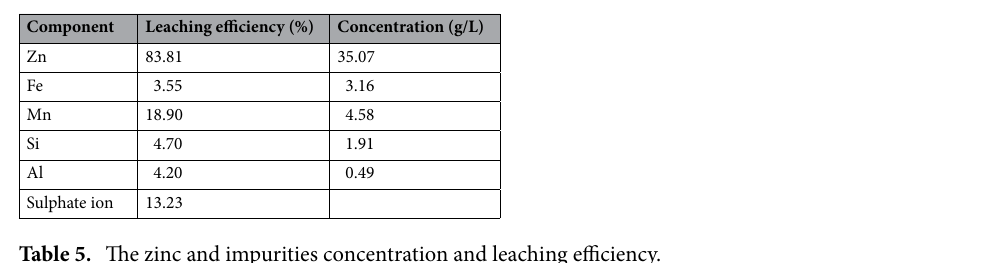
Table 5. The zinc and impurities concentration and leaching